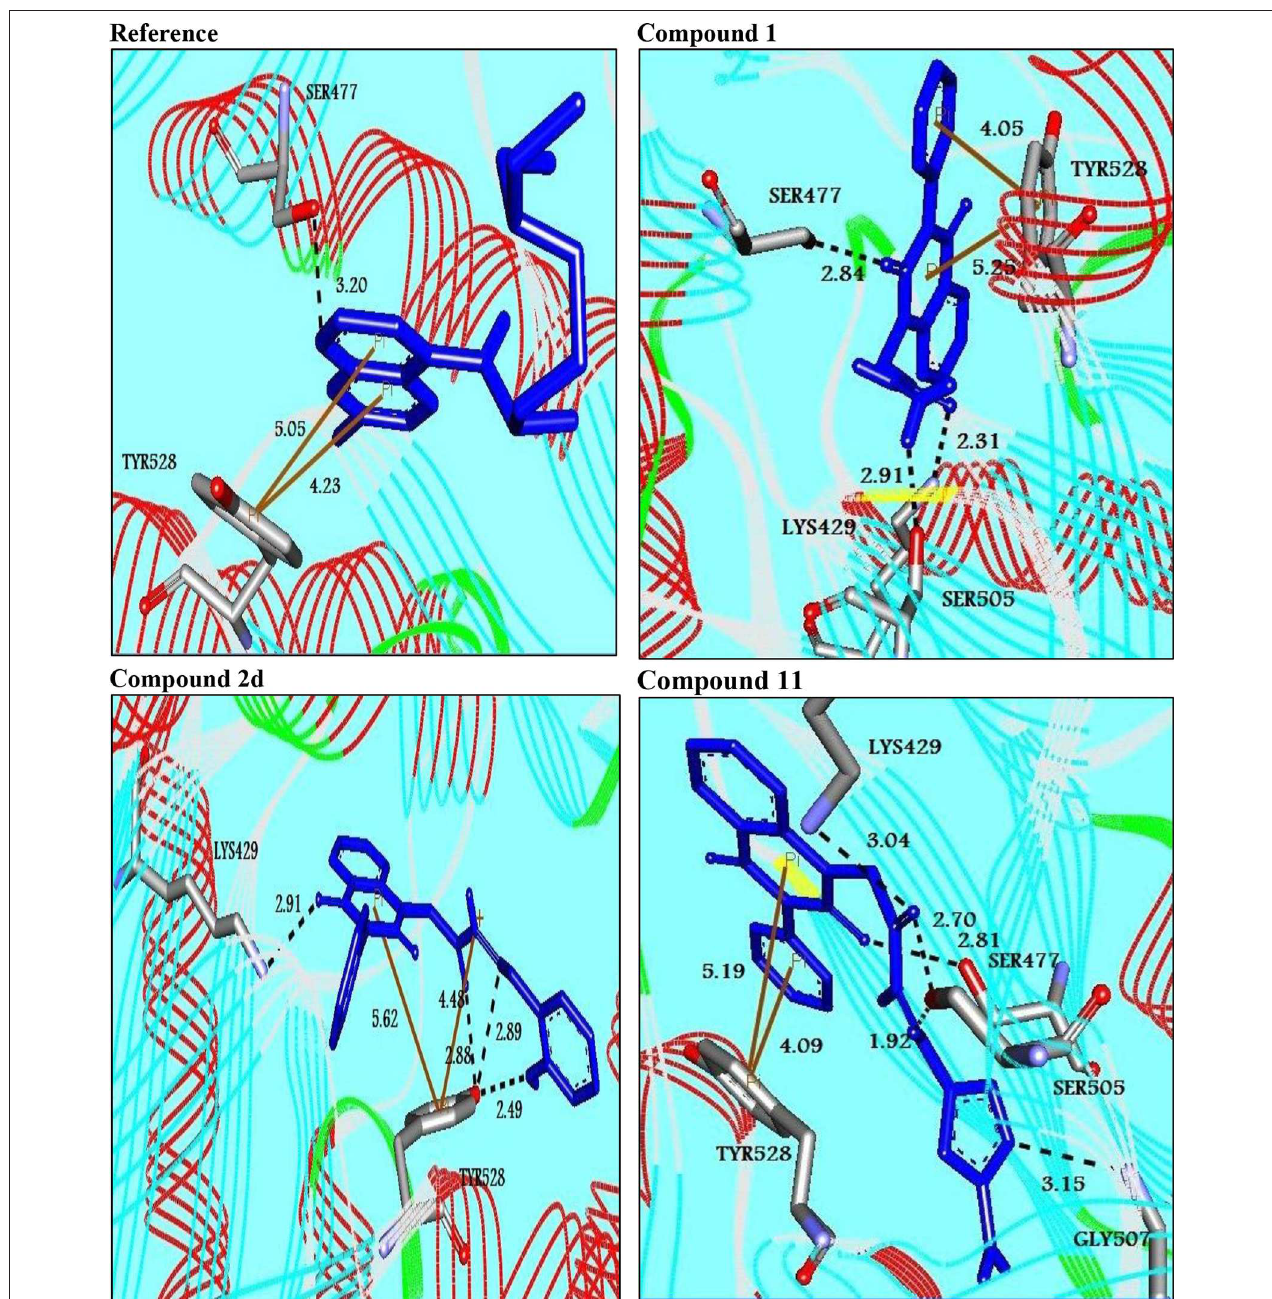
FIGURE 1 | Molecular interactions between the best binders and pf DHODH. Three-dimensional of docking poses of the reference and three best binding compounds in the active pocket of pf DHODH. Blue stick models represented the docked compounds, and gray models represented the active site region. H-bond interactions are shown in black dotted lines. π - interactions are shown in orange